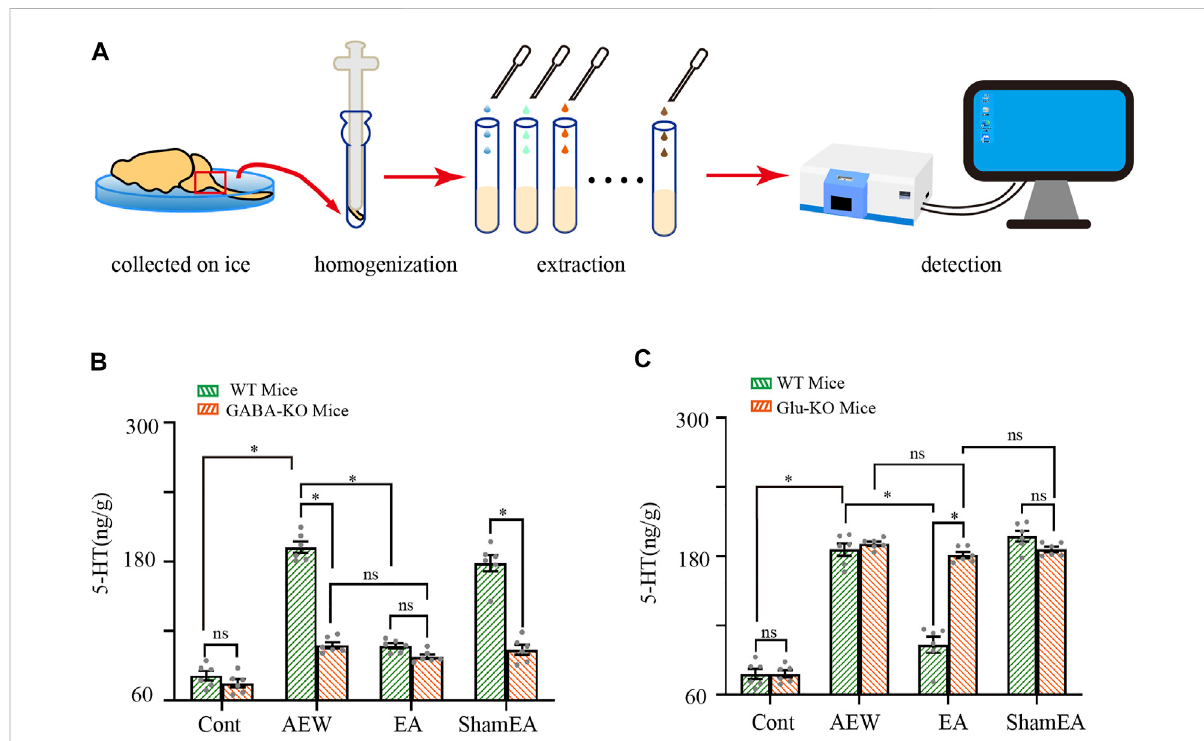
FIGURE 6 Comparison of the effects of EA on 5-HT in wild-type mice and CB1-KO mice. (A) Schematic showing the measurement of 5-HT. (B) Summary data show the effect of EA on the 5-HT concentration in the medulla of wild type mice and GABA -CB1 − / − mice. ( n = 10 mice in CB1-KO mice, n = 6 mice in wild-type mice). (C) Summary data show the effect of EA on the 5-HT concentration in the medulla of wild-type mice and glutamatergic -CB1 − / − mice. Data are expressed as means ± SEM ( n = 10 mice in CB1-KO mice, n = 6 mice in wild type mice). * p <